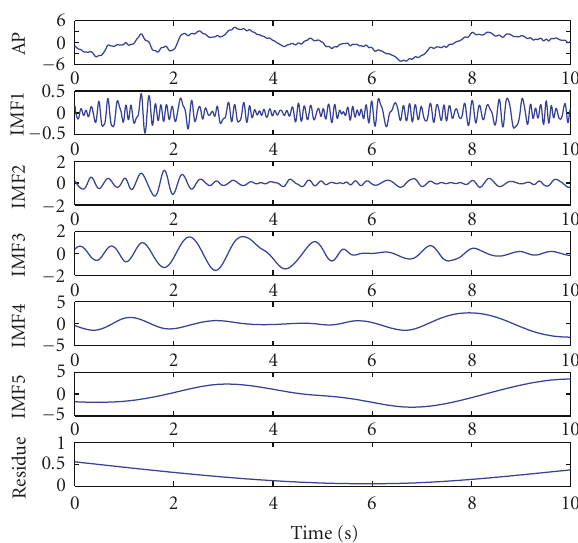
Figure 2: EMD decomposition of the 10-second anteroposterior displacement time series in Figure